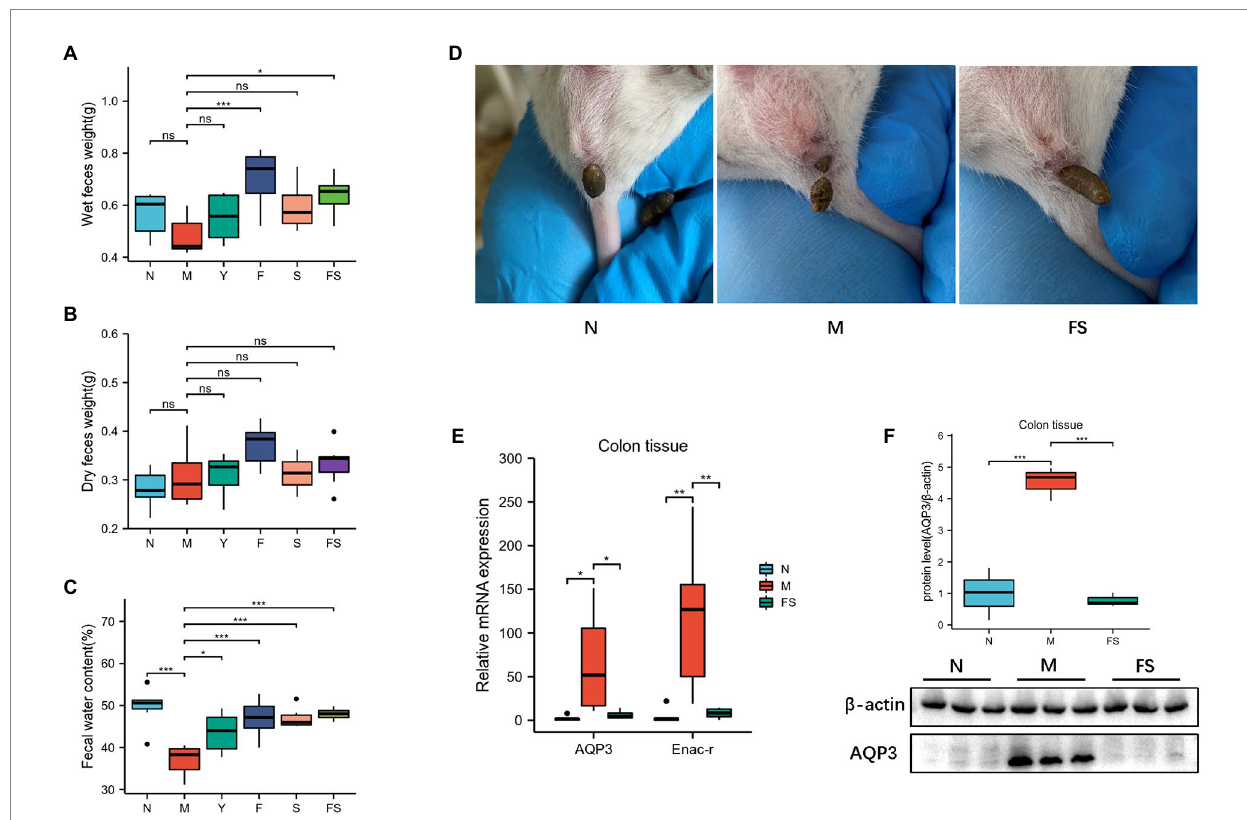
FIGURE 2 Postbiotic of hawthorn-probiotic maintain the stability of water and sodium metabolism and increase fecal water content. (A) Wet feces weight; (B) Dry feces weight; (C) Fecal water content (wet feces weight/dry feces weight); (D) Fresh feces in three groups of mice; (E) Relative mRNA expression of AQP3 and Enac- γ ; (F) AQP3 protein level. NS; * p < 0.05; ** p < 0.01; *** p <